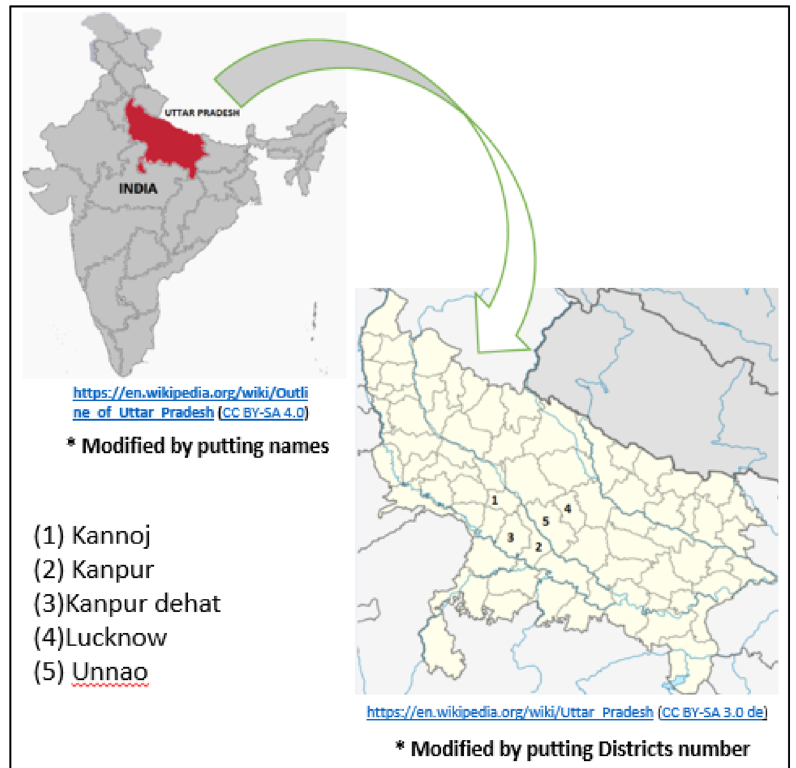
Figure 3. Districts from where most patients visited CCC.